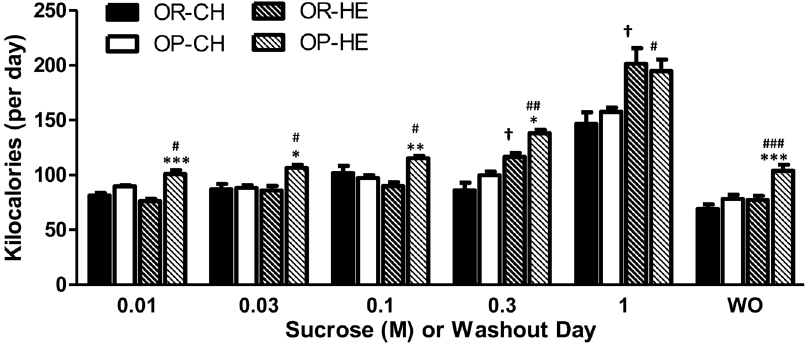
Figure 3. Total daily energy intake during 48-h two-bottle sucrose testing and washout days. During HE-feeding, OP rats consumed more total calories at all tests and washouts, except for 1.0 M sucrose, compared to OR rats. HE-feeding resulted in increased energy intake during tests of all sucrose concentrations for OP rats compared to chow counterparts. *P , 0.05, **P , 0.001, ***P , 0.0001 OP relative to OR within diet condition; { P , 0.05 HE-OR relative to chow-OR; # P , 0.05, ## P , 0.001, ### P , 0.0001 HE-OP relative to